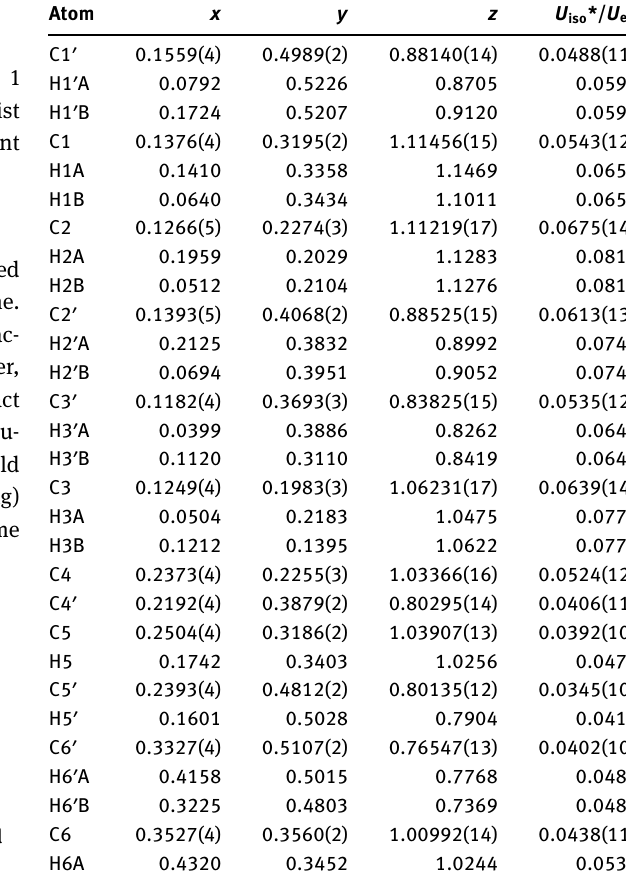
Table 2: Fractional atomic coordinates and isotropic or equivalent isotropic displacement parameters (Å 2